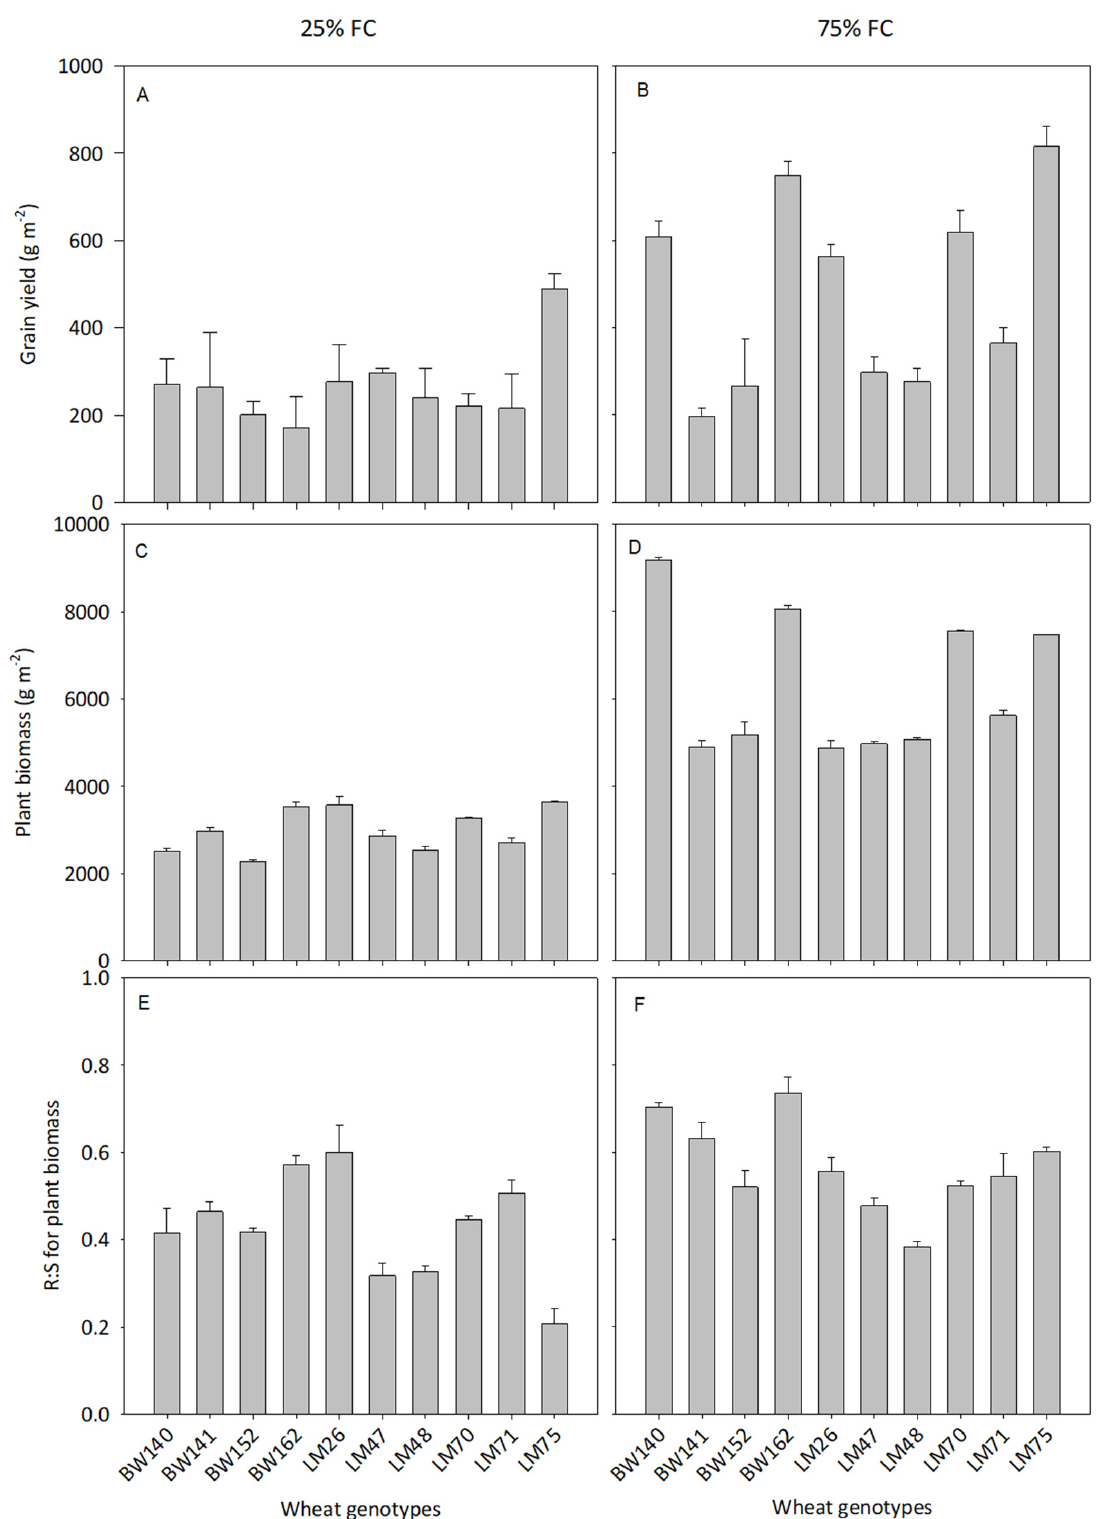
Figure 3. Variation in grain yield ( A , B ), plant biomass ( C , D ) root to shoot ratio for plant biomass ( E , F ) due to genotype and soil water availability (25 and 75% field capacity) under greenhouse conditions. Data are mean and standard errors (n = 9).